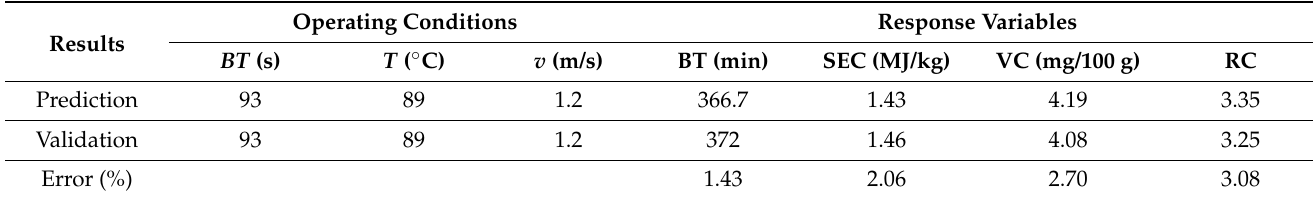
Table 5. Prediction and validation results of response variables under the optimal processing